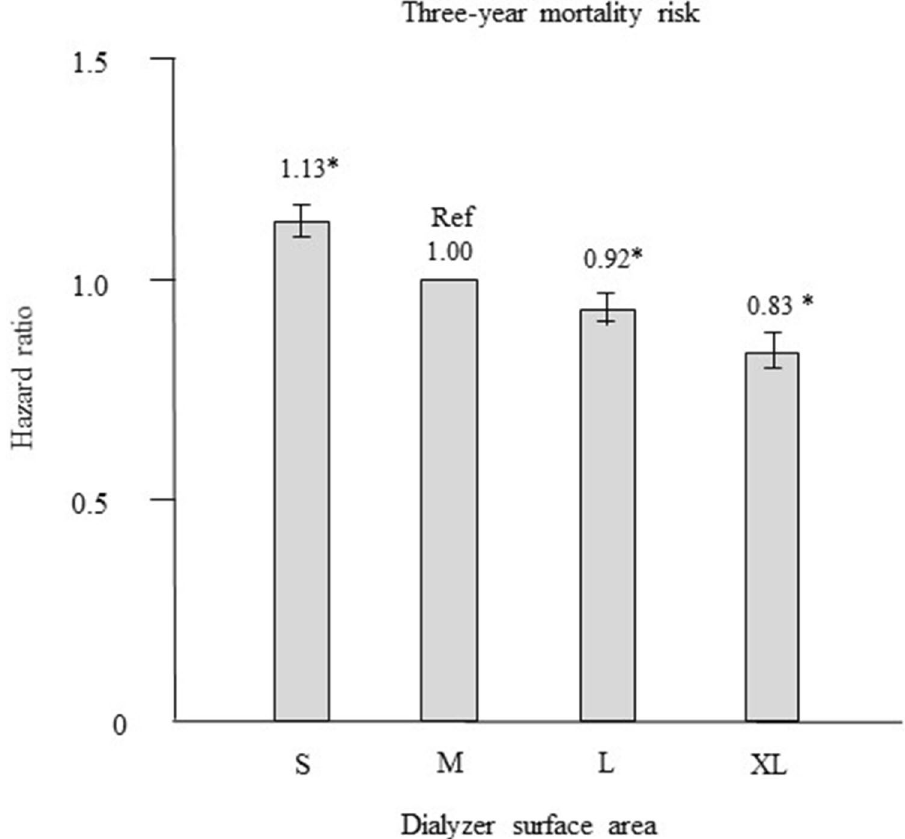
Figure 6. Hazard ratios for all-cause mortality for the three dialyzer surface area groups versus the reference group after propensity score matching using a Cox proportional hazards regression model. * P < 0.0001 versus M group. Error bars correspond to 95% confidence intervals. S group, small dialyzer surface area, < 1.5 m 2 ; M group, medium dialyzer surface area, 1.5 m 2 ; L group, large dialyzer surface area, 1.6 to < 2.0 m 2 ; XL group, extra-large dialyzer surface area, ≥ 2.0 m 2